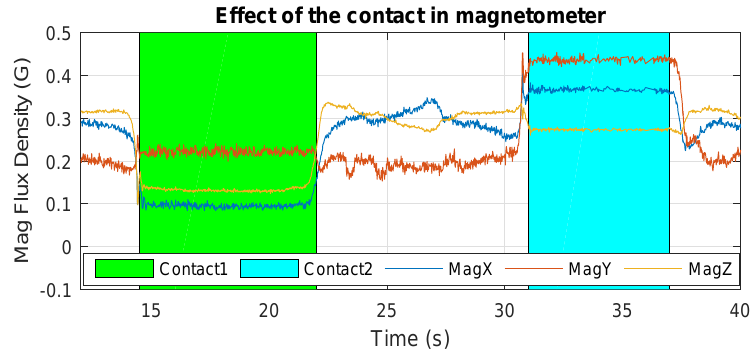
Figure 16. Magnetic-flux density—Cartuja bridge